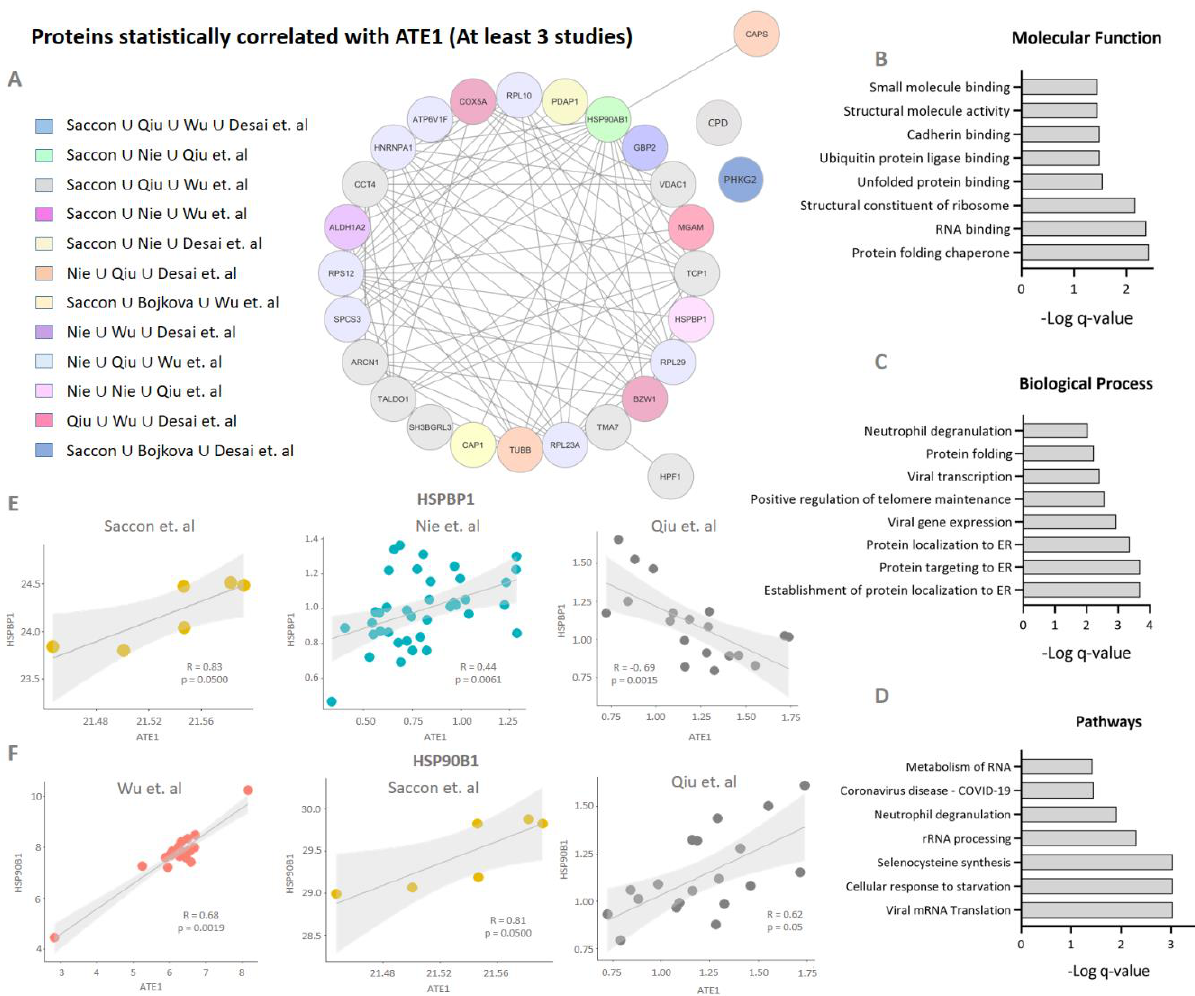
Figure 3. Multi-correlation expression analysis. ( A ) Proteins and genes correlated with ATE1 ex- pression in at least three reanalyzed studies. The correlation analysis was determined by applying the Spearman test with a cut-off significance of p -value < 0.05. Only differentially regulated pro- teins/genes were considered for the correlation analysis; ( B ) gene ontology (GO) analysis of molecular functions; ( C ) biological processes and ( D ) pathways related to proteins/genes correlated with ATE1 in at least three studies; ( E ) correlation graph of HSPBP1 and ( F ) HSP90AB1 proteins indicates the positive/negative correlation with ATE1.